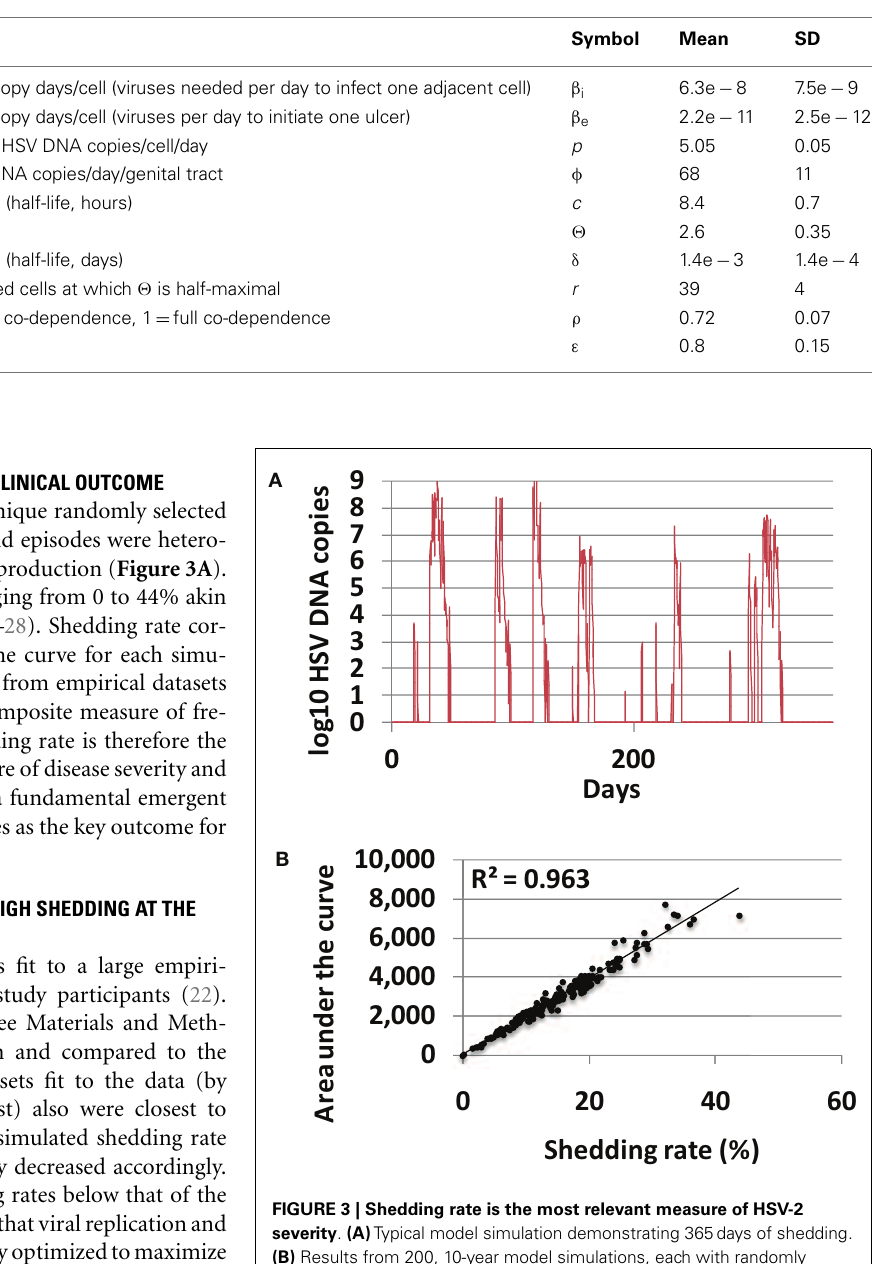
Table 1 | Parameter ranges used for sensitivity analysis.